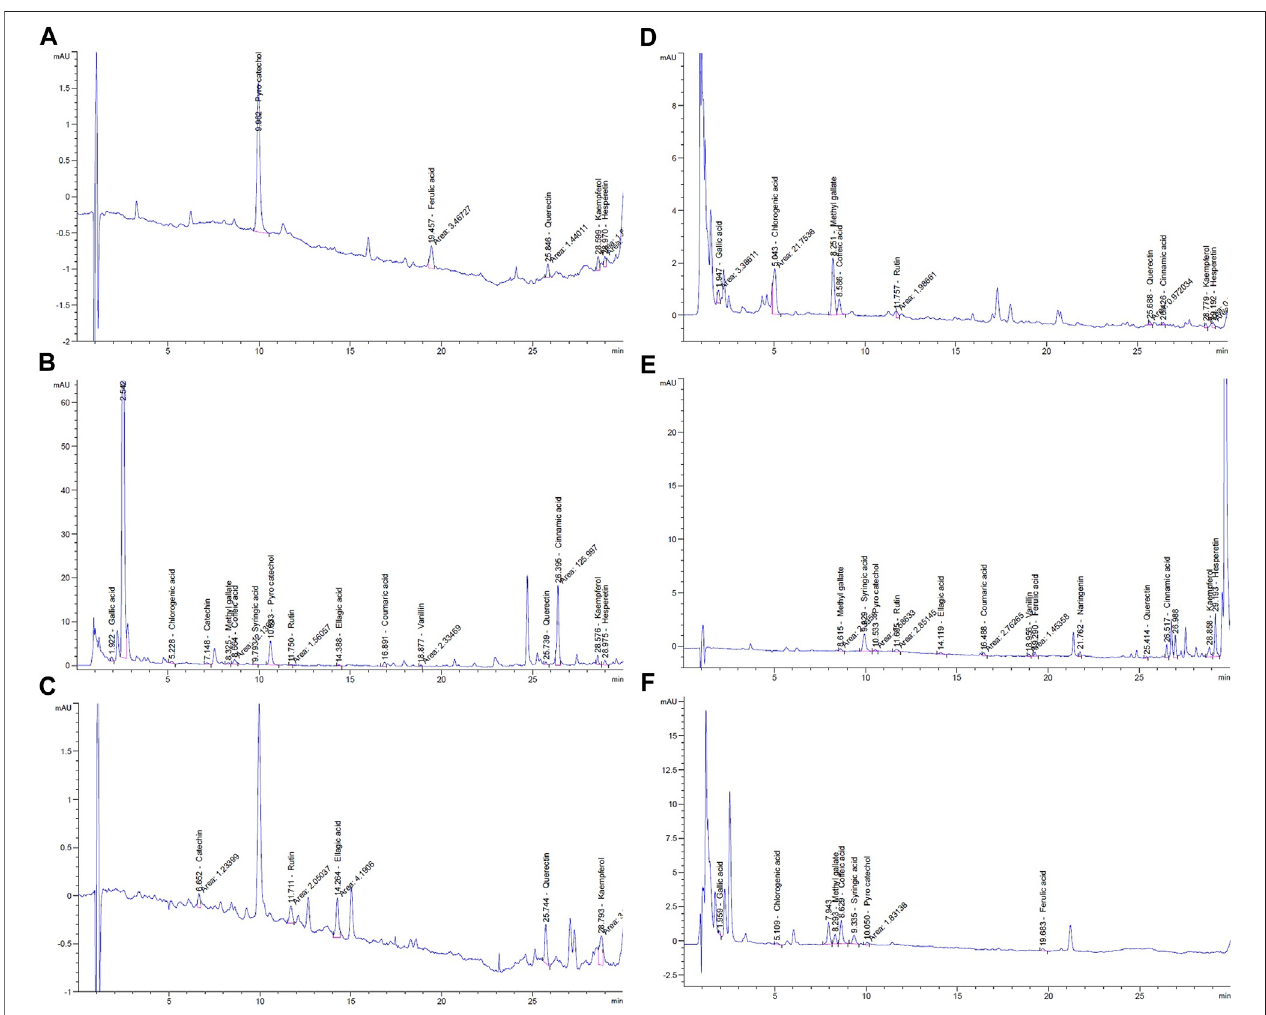
FIGURE 4 | HPLC chromatograms of phenolic components in n -butanol extracts from: (A) N. sativa seeds; (B) endophytic fungus A. niger ; (C) P. oleracea seeds; (D) endophytic fungus C. madrasense; (E) D. viscosa seeds; (F) endophytic fungus R. oryzae .